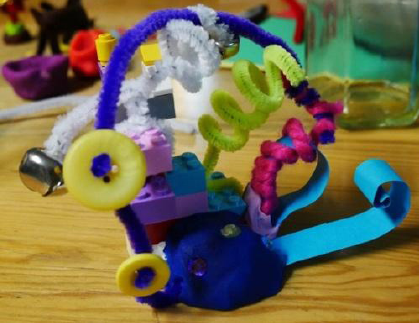
Figure 1. The fish thing (source: created by authors)